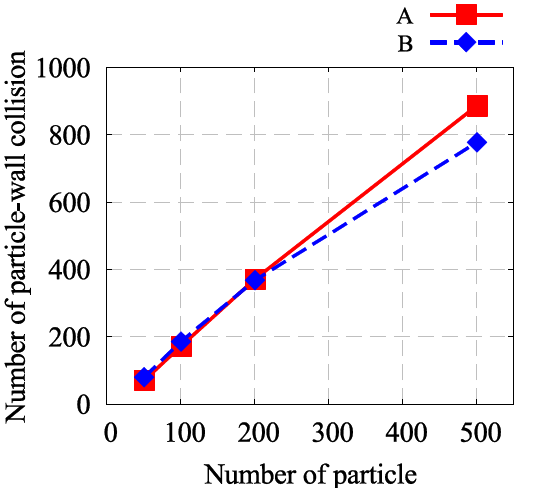
Figure 26. Number of collisions between the wall and the many particles. Red and blue plots pertain to scheme A and B, respectively. Figure 27 visualizes the distribution of the collision points on the wall in the one cell painted. The irregular distribution was attributed to the initially random particle dispositions. Although the initial particle positions were the same in both schemes, the distributions were clearly different. For schemed A200 and B200, the numbers of collisions between particle and wall were almost the same in Figure 26, however, the locations of collision points were